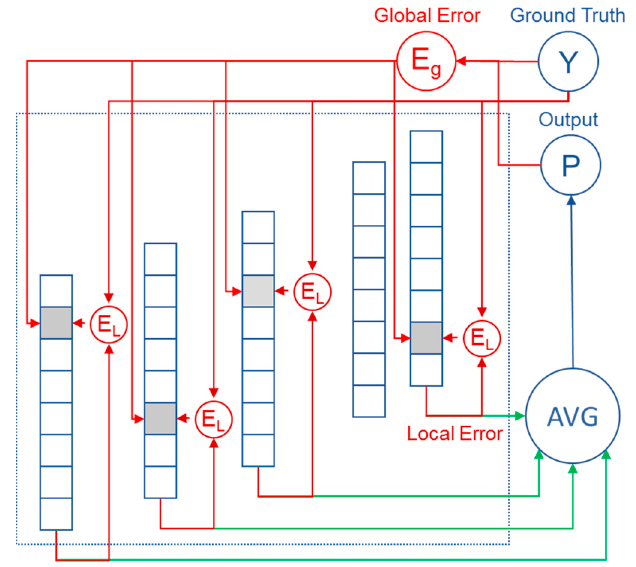
Figure 5. Block scheme for the proposed update algorithm.